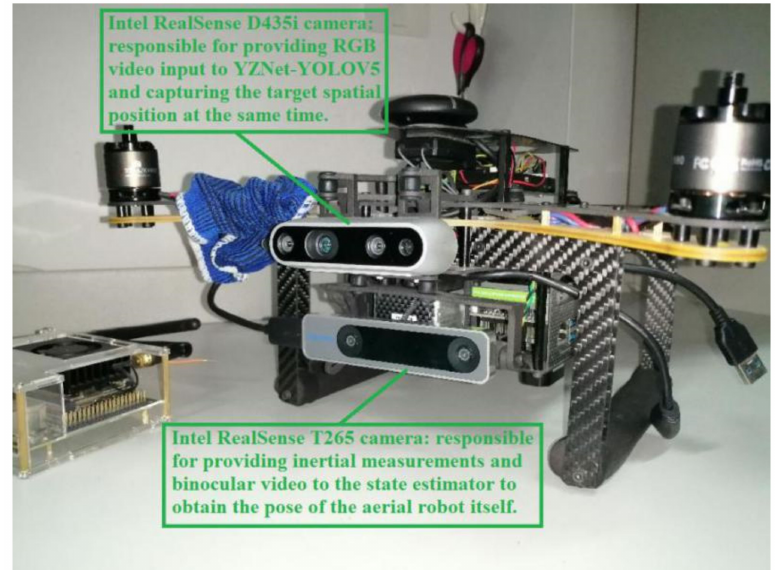
Figure 1. The aerial robot equipped with the RPEOD